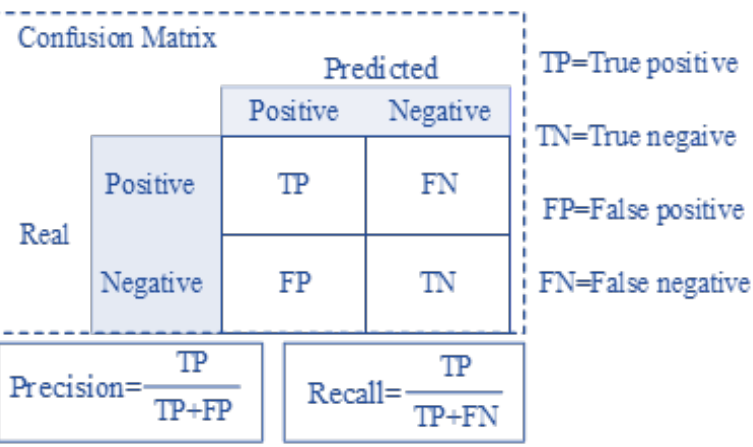
Figure 15. Calculation of precision and